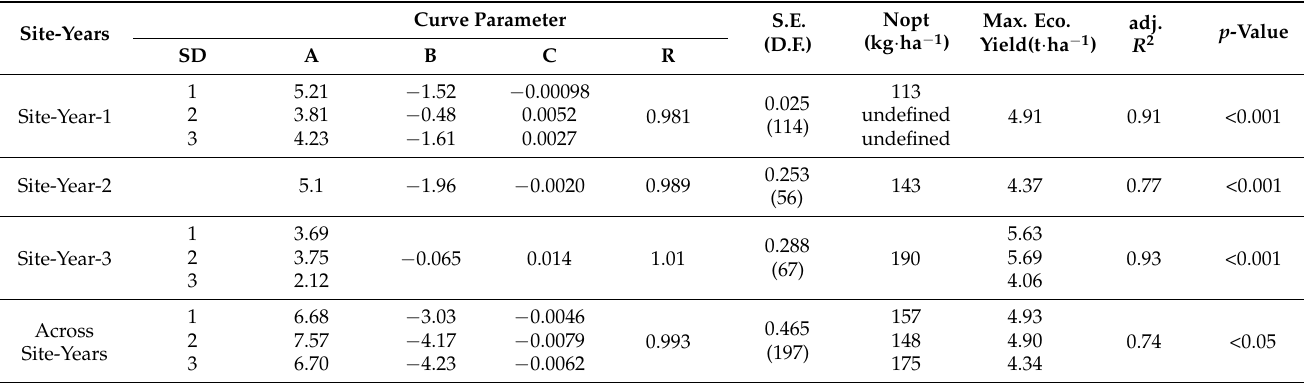
Table 7. Selected FNUpE closest to Nopt to define the best N strategy, N rates, and SDs for each separate year and SD.